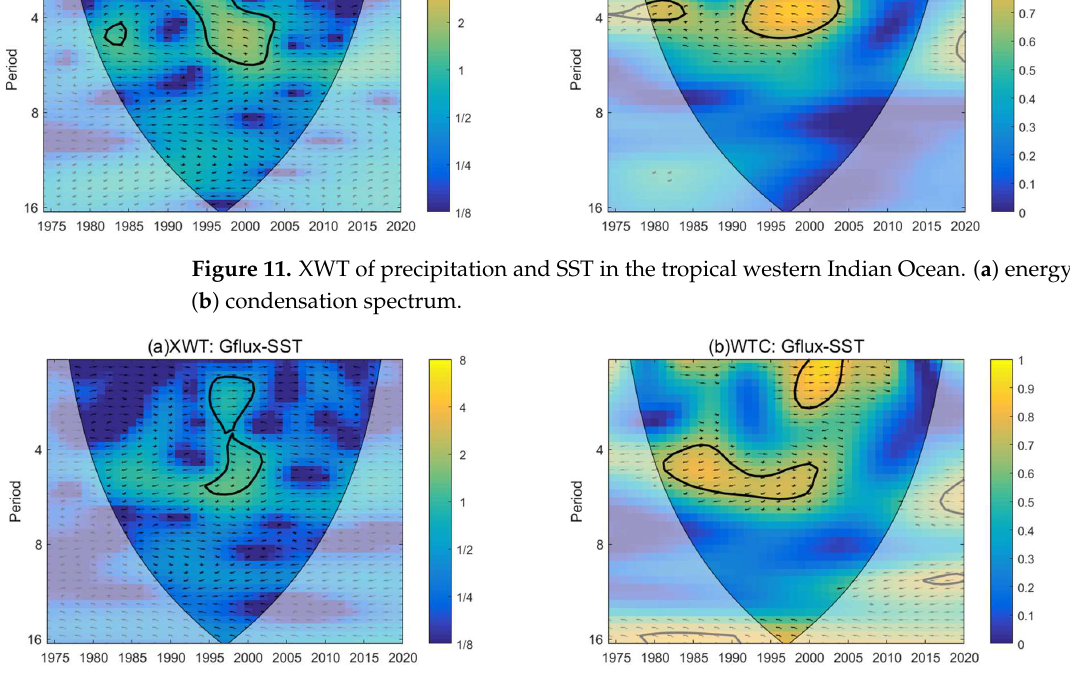
Figure 11. XWT of precipitation and SST in the tropical western Indian Ocean. ( a ) energy spectrum; ( b ) condensation spectrum.